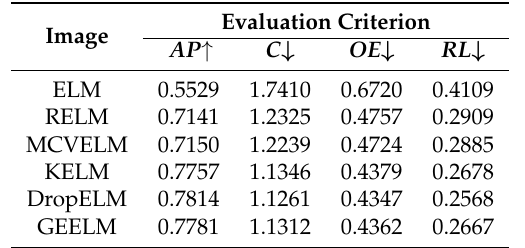
Table 6. The effectiveness comparison of Extreme Learning Machine (ELM)and its variants on the Image dataset.